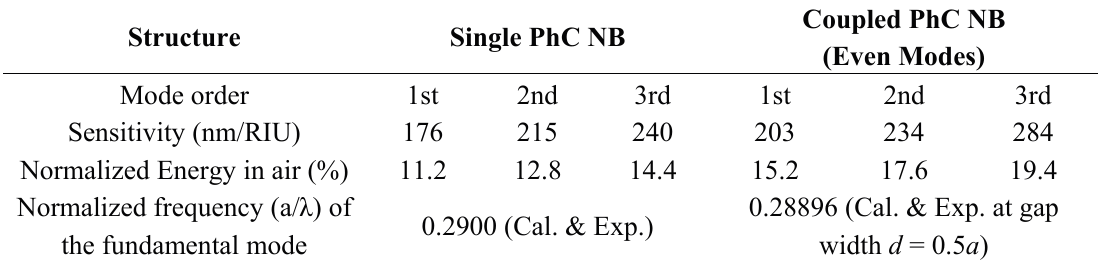
Figure 6. Normalized electric field energy percentage in air for the single and laterally-coupled PhC NB cavities. Table 1. A comparison between the single PhC NB cavity and the laterally-coupled PhC NB cavities (even